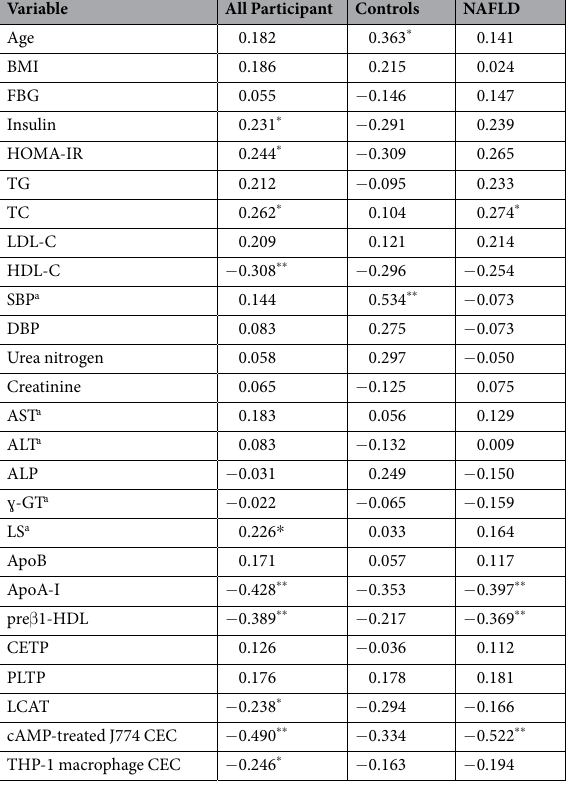
Table 3. Pearson correlation of cIMT with anthropometric and metabolic profiles. * p < 0.05 and ** p < 0.01. a Logarithmic transformation was